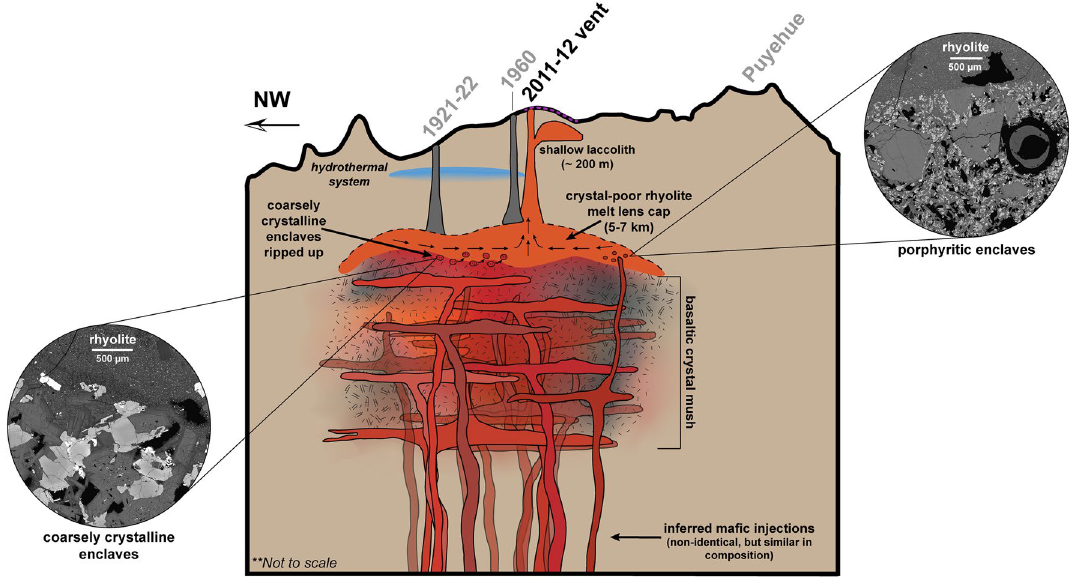
Figure 6. Schematic diagram for Cordón Caulle plumbing system (not to vertical scale). Inferred mafic injections 22 fuel overlying crystal mush. Shades of orange-red in mafic injections and crystal mush represent compositional heterogeneity observed in chemistry. Stippled texture in crystal mush represents different levels of crystallinity. Black portions of crystal mush represent low-melt content or inactive heterogeneities within the mush. Crystal mush is overlain by crystal-poor rhyolite (orange). Coarsely-crystalline fragments are entrained into rhyolite prior to or upon eruption preserving remnants of the mush in the form of mafic enclaves. Some injections bypass the mush chemically unobstructed and interact directly with rhyolite to form porphyritic enclave population. Arrows in rhyolite melt cap represent June 4–7, 2011 magma flux 22 . Dashed purple line: surficial uplift from laccolith emplacement. Circular outsets are BSE images of enclave-host boundary for both enclave populations. Schematic does not infer magmatic architecture underlying Puyehue